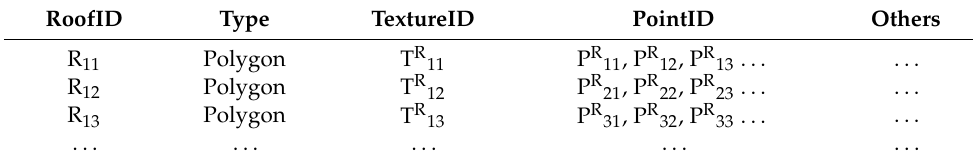
Table 7. The relationship of building roof textures.